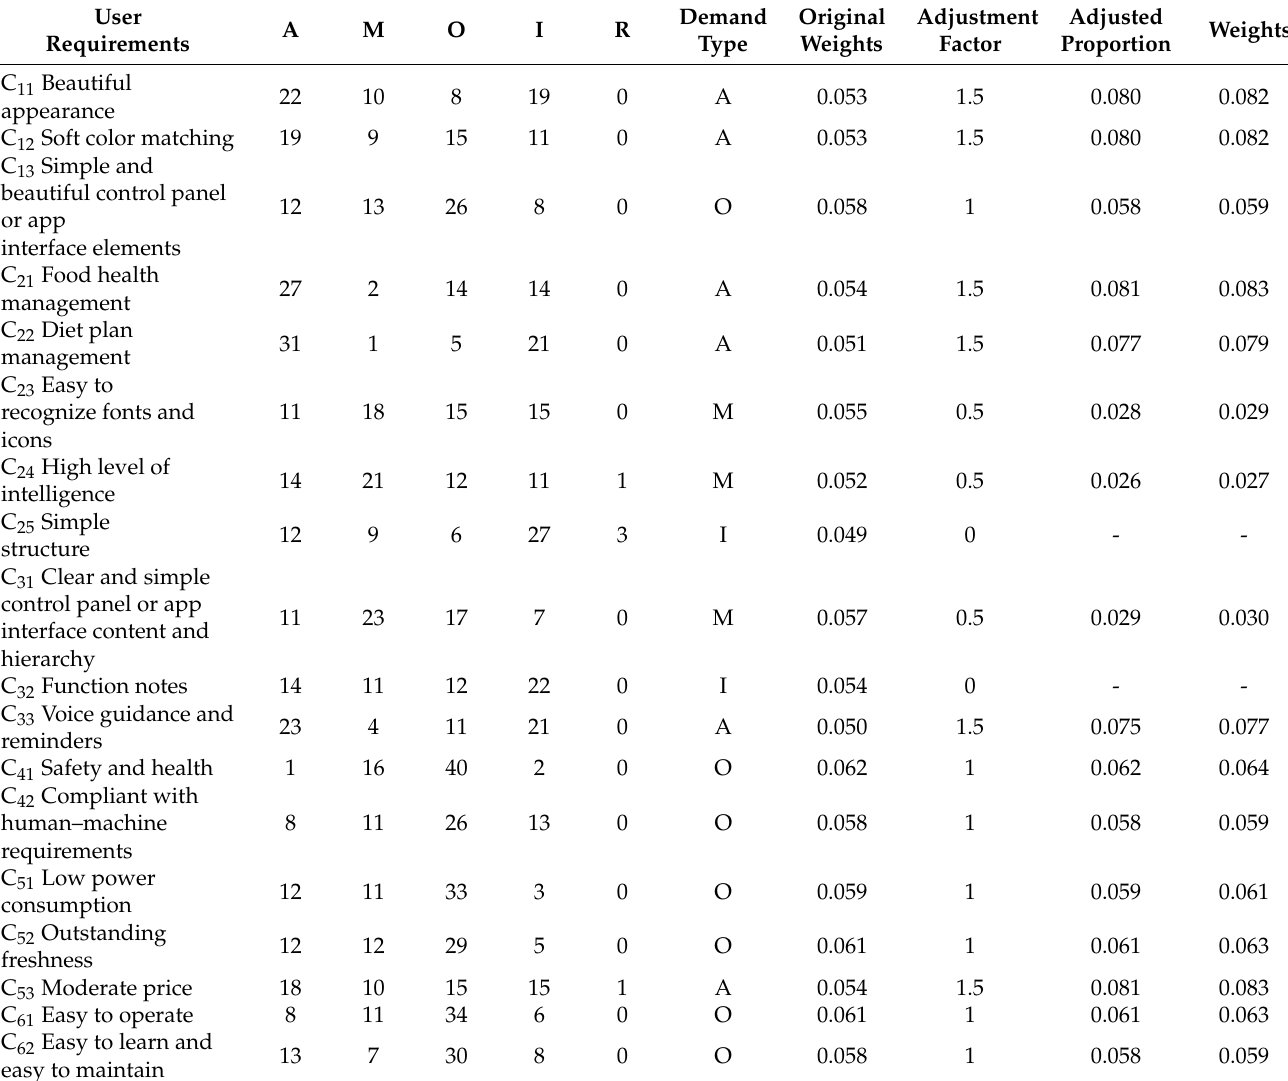
Table 2. List of importance of user